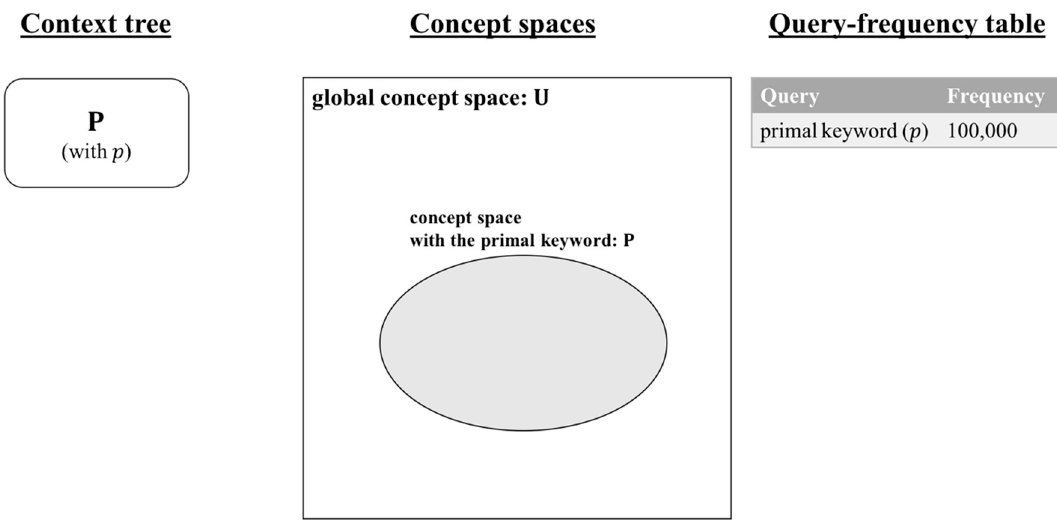
Figure 2. Initializing the Context Tree using the primal keyword.